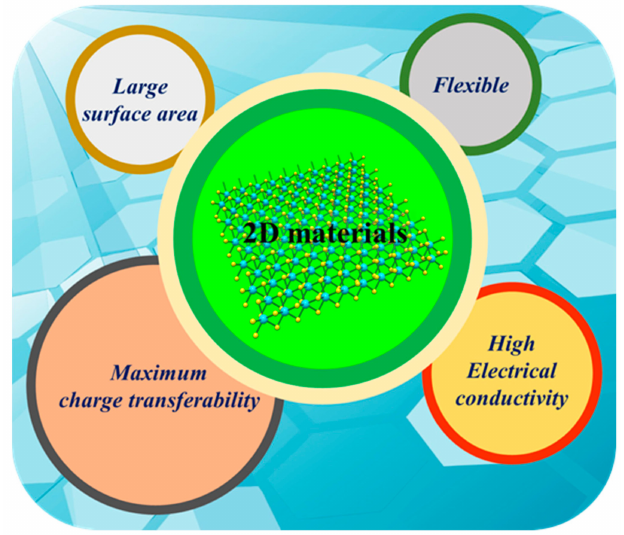
Figure 2. Schematics showing the properties of 2D